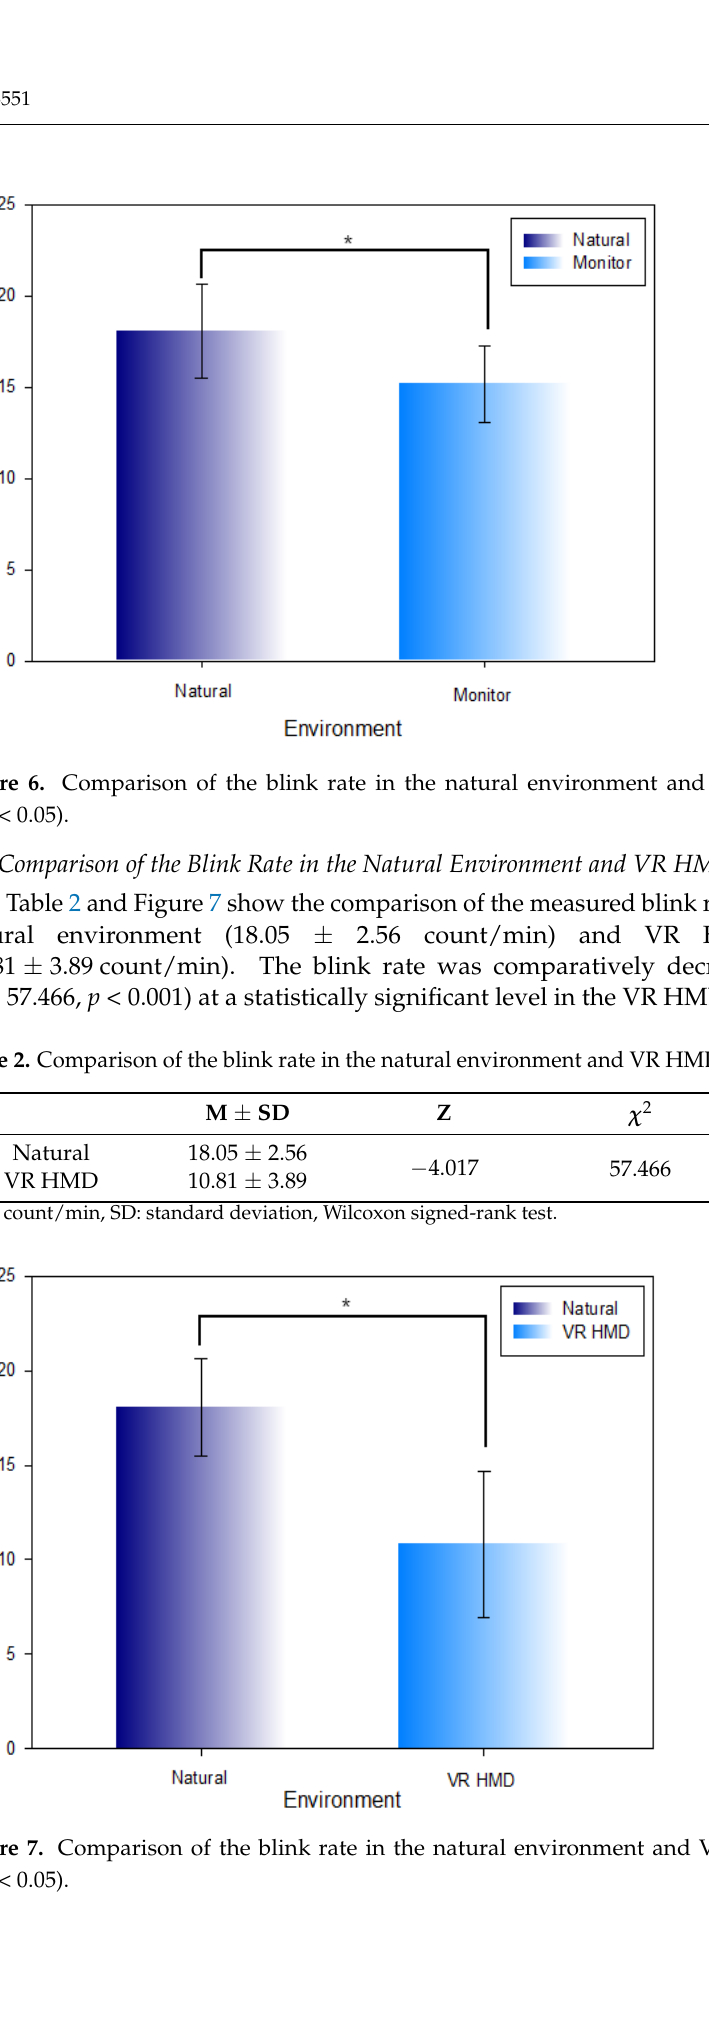
Table 1. Comparison of the blink rate in the natural environment and monitor environment ( n = 21).